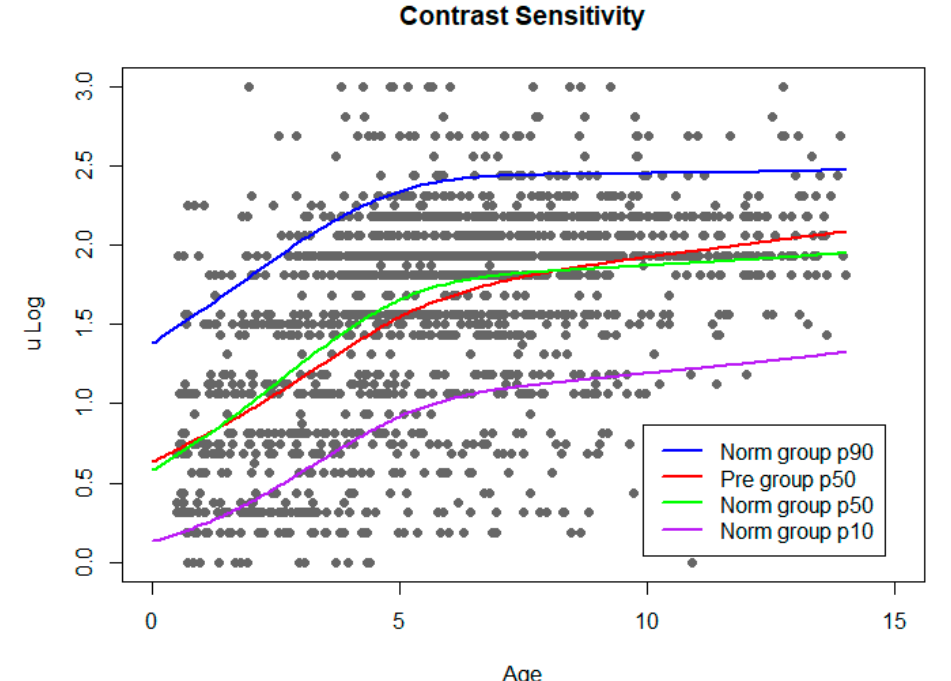
Figure 4. CS norm curve. Grey dots represent CS results from Norm group. Adjusted normal percentiles (10, 50, and 90) are shown as colour lines. Percentile 50 of Pre group was plotted on the graph.